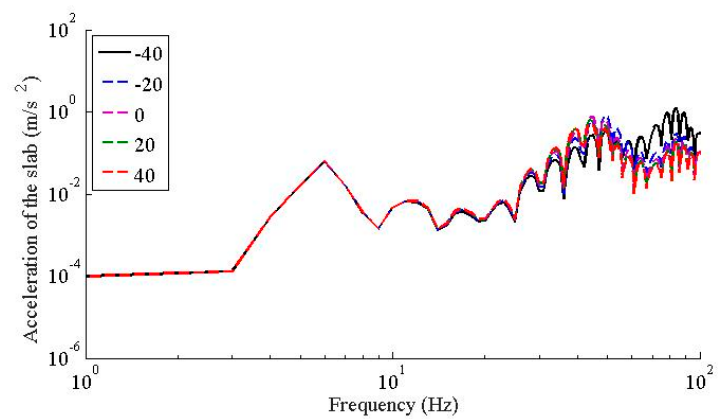
Figure 13. Vertical acceleration of the track slab under − 40, − 20, 0, 20, and 40 °C.